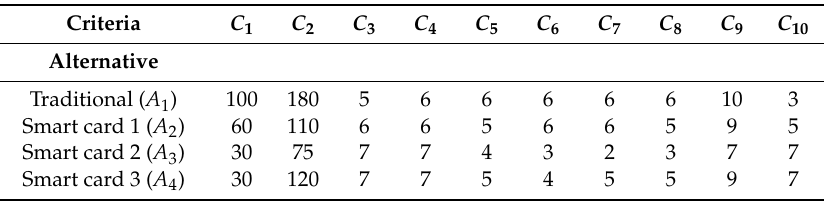
Table A3. Initial decision matrix filled by DM3 for WASPAS analysis.